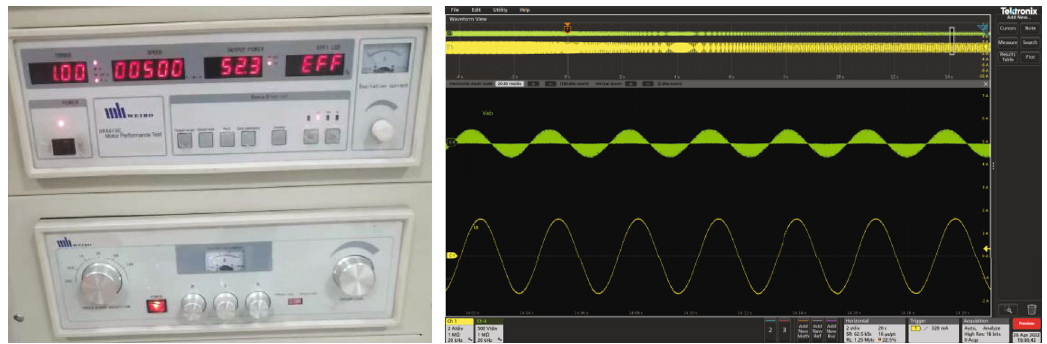
Figure 32: Phase current waveform, torque, and speed measurement for proposed